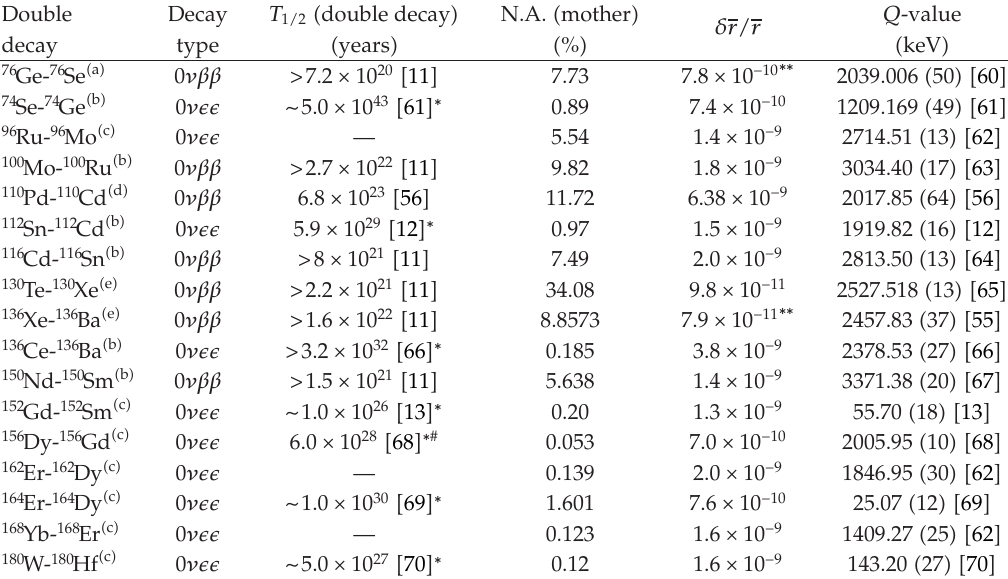
Table 1: Q -values for double β transformations determined from Penning-trap mass measurements on the mother and the daughter nuclei. In case where the measurement was performed at two di ff erent Penning- trap facilities, only the value with smaller relative mass uncertainty is shown.